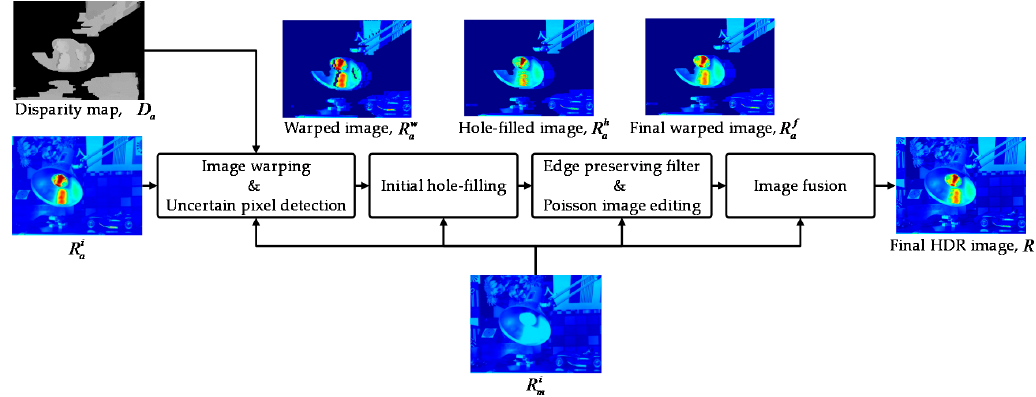
Figure 8. A flow chart of the hole-filling and the fusion process.